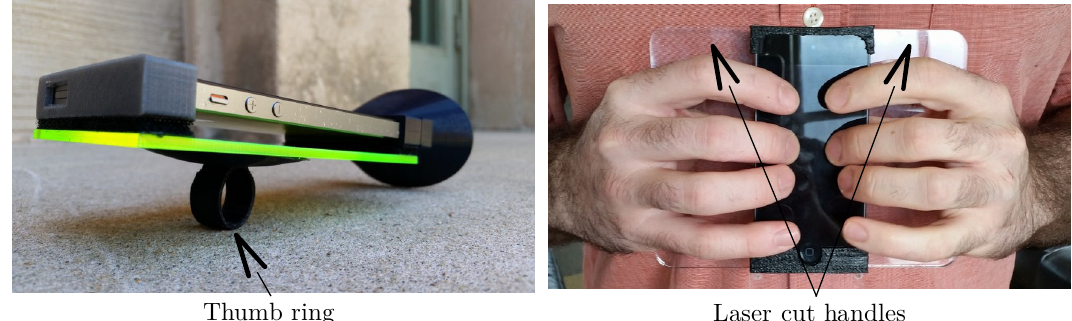
Figure 9. Thumb-held mobile-device-based musical instrument ( on the left ) and smart-phone Thumb ring Laser cut handles augmented to be held as a wind instrument ( on the right